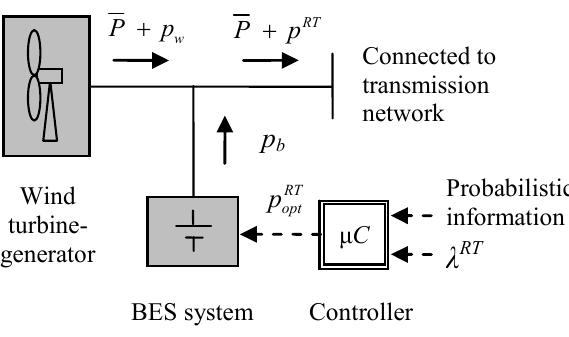
Figure 3. Outline of WGS with